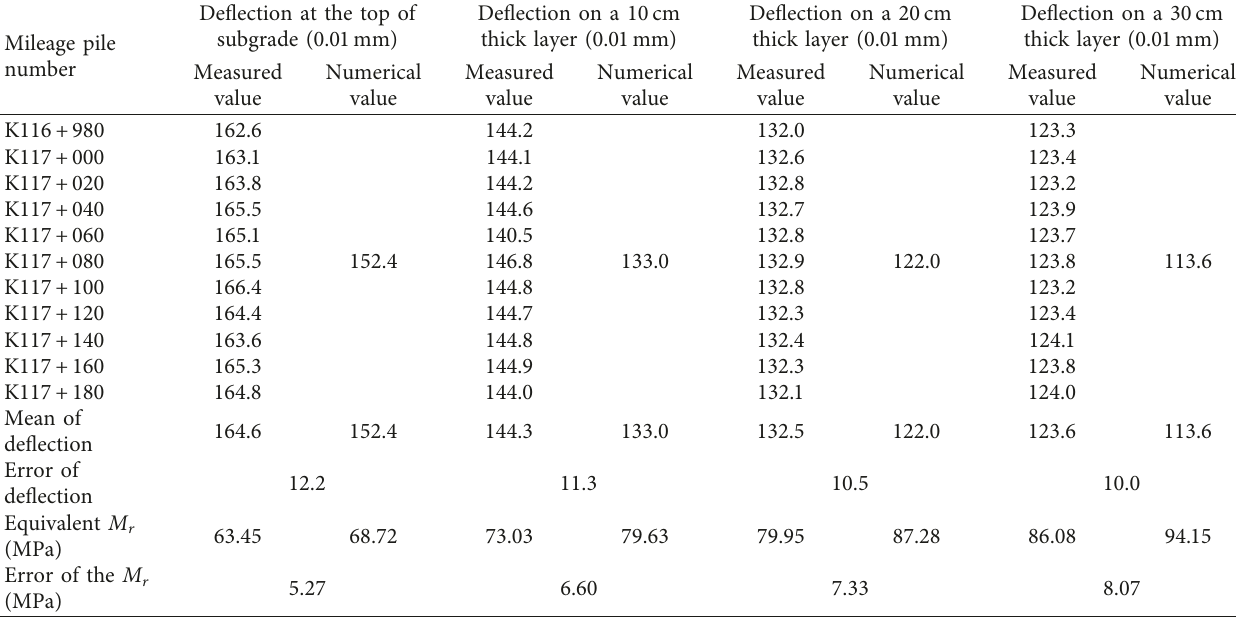
Table 1: Results of the numerical value and PFWD-measured value of deflection at the center belt. Mileage pile